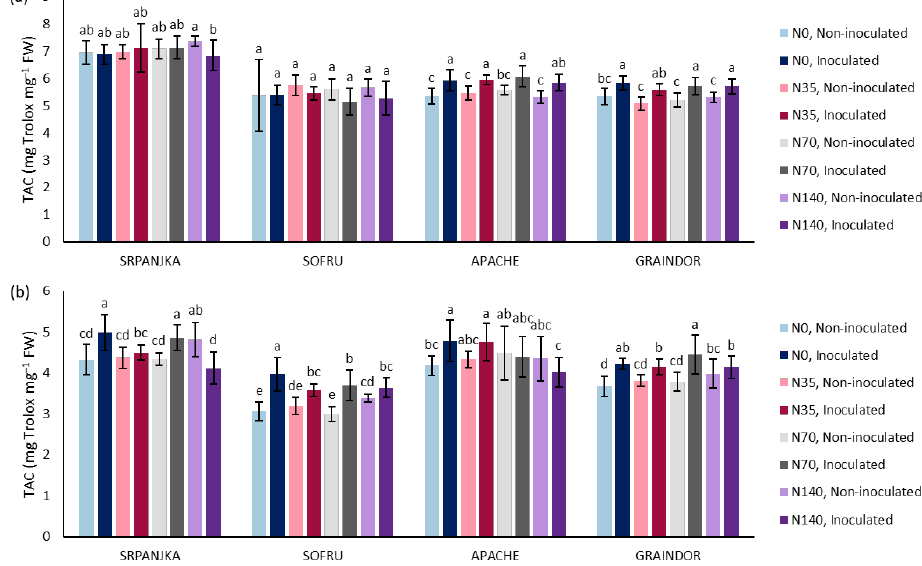
Figure 5. Total antioxidant capacity (TAC) in spikes of four wheat varieties under different Fusarium (non-inoculated and inoculated) and nitrogen treatments (0, 35, 70, and 140 kg N ha − 1 ) in 2018/2019 ( a ) and 2019/2020 ( b ). Values are means of eight replicates ± standard deviation (SD). Different letters above the bars indicate significant differences according to Fisher’s LSD test ( p ≤ 0.05) among treatments in each variety separately.